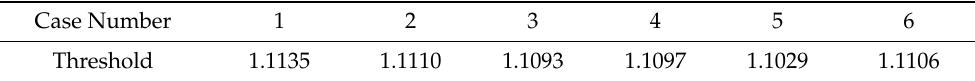
Table 3. Thresholds of the 𝑃𝑅 (cid:3045) images, the values of which are obtained according to the Euclidean distance-based threshold method, with four decimal points retained in the table.